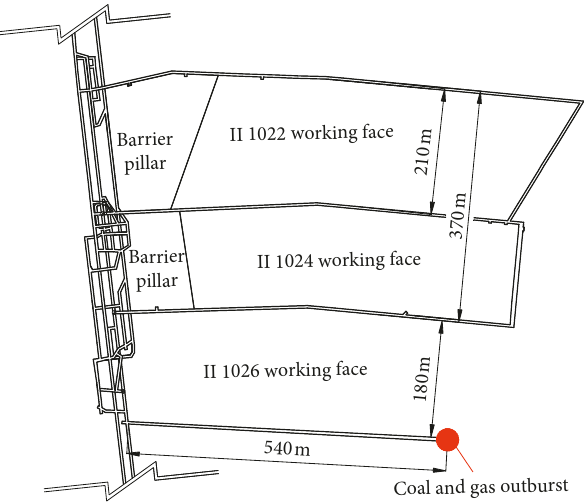
Figure 4: Layout sketch map of the working area in the Haizi coal